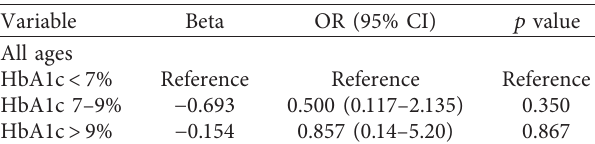
Figure 2: Prevalence of subclinical hypothyroidism in the three categories of Table 2: Multivariate logistic regression analysis of the association between subclinical hypothyroidism and glycemic control in pa- tients with type 2 diabetes mellitus.